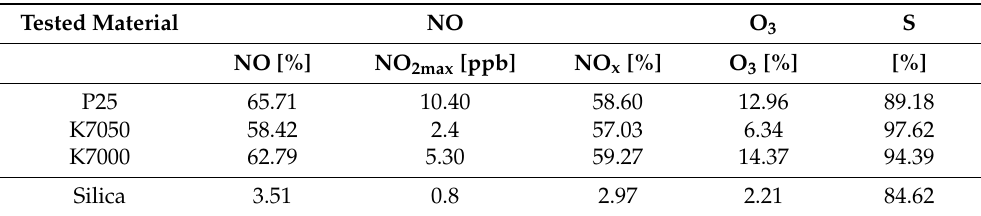
Table 2. Results of the oxidation of NO and O 3 in the photocatalytic reaction under UVA irradiation for the studied powders and silica fume. NO, NO 2max , and NO x refer to NO oxidation, O 3 refers to pure ozone oxidation, and S refers to the calculated selectivity of the NO reduction